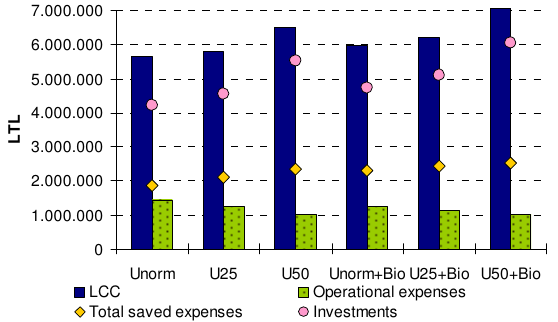
Fig. 3. Economic efficiency of alternatives